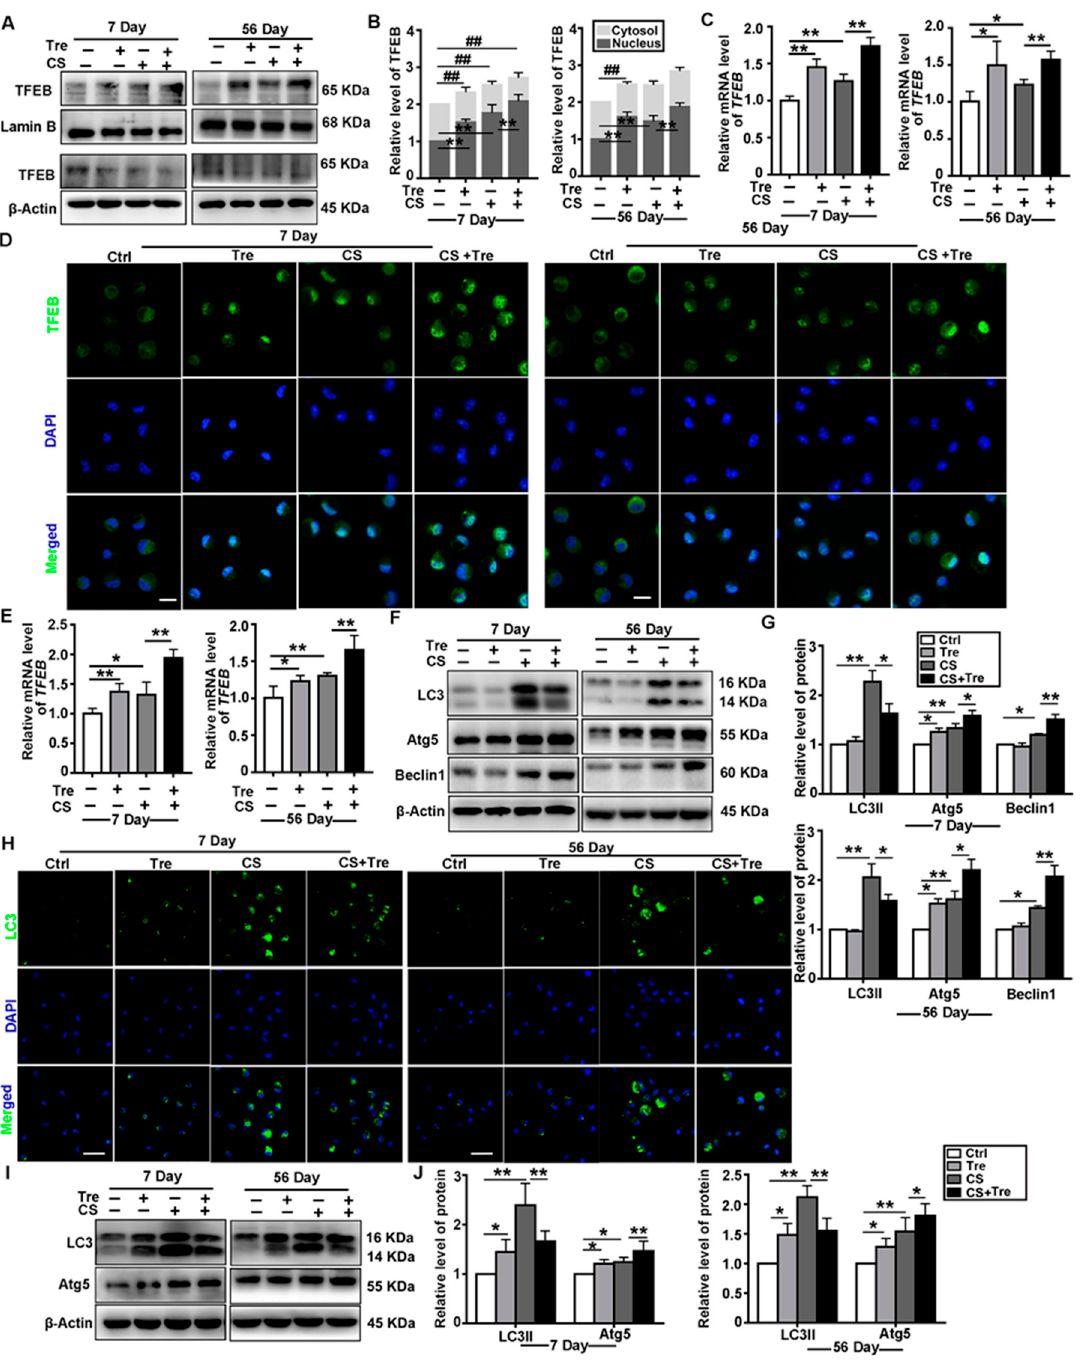
Figure 4. Trehalose (Tre) affects autophagy-associated proteins in the lungs and AMs of CS-treated mice. ( A , B ) Immunoblotting analysis of cytosol and nuclear TFEB levels in lung tissue on day 7 or 56 post CS or Tre treatment; β -actin, loading control for cytosolic proteins; and LaminB, loading control for nuclear proteins ( n = 3 to 4). ( C ) qPCR analysis of TFEB levels in lung tissue on day 7 or 56 post-CS or Tre treatment ( n = 4). ( D ) Immunofluorescence analysis of TFEB nuclear translocation in primary AMs in BALF on day 7 or 56 (scale bar = 10 µ m and n = 3 to 4). ( E ) qPCR analysis of TFEB expression in AMs on day 7 or 56 post CS or Tre treatment ( n = 4). ( F , G ) Immunoblotting analysis of LC3II, Atg5, and Beclin 1 protein levels in lung tissue on day 7 or 56 post CS and Tre treatment ( n = 5 to 6). ( H ) Immunofluorescence analysis of LC3 in AMs on day 7 or 56 post CS or Tre treatment (Scale bar = 25 µ m and n = 3). ( I , J ) Immunoblotting analysis of LC3II and Atg5 protein levels in AMs on day 7 or 56 post CS or Tre treatment ( n = 3 to 4). Data are presented as the mean ± SD. *, p < 0.05; **, p < 0.01; and ##, p < 0.01.